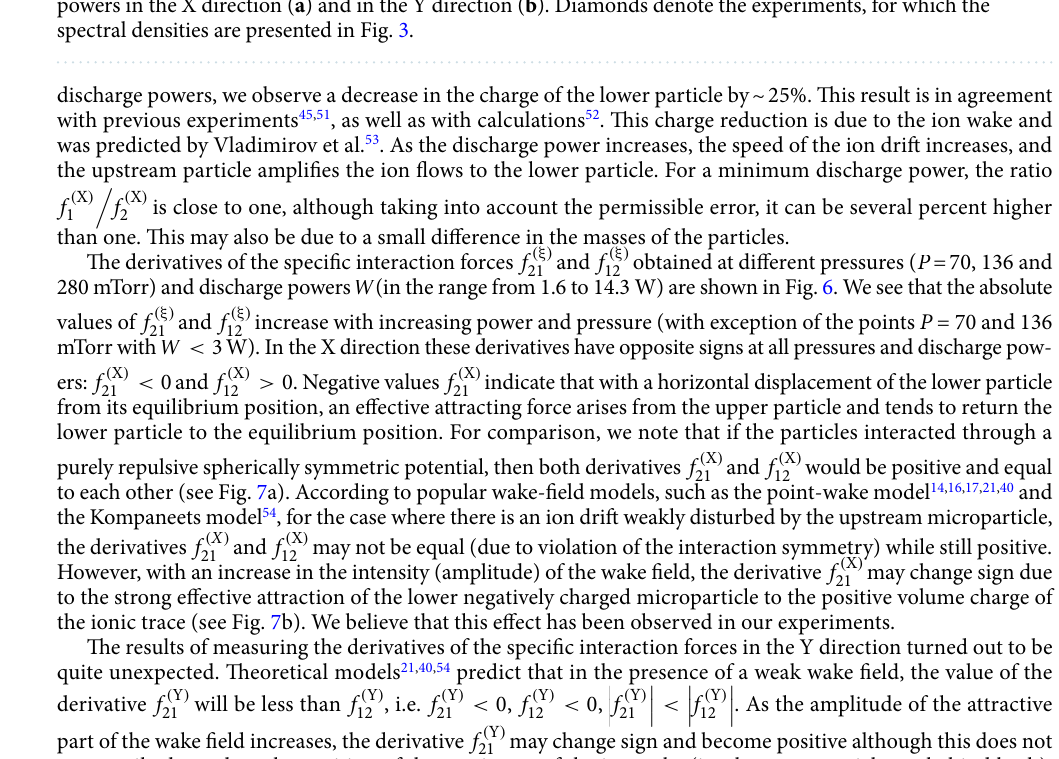
( ξ ) ( ξ ) 21 and f 12 obtained at different pressures and RF